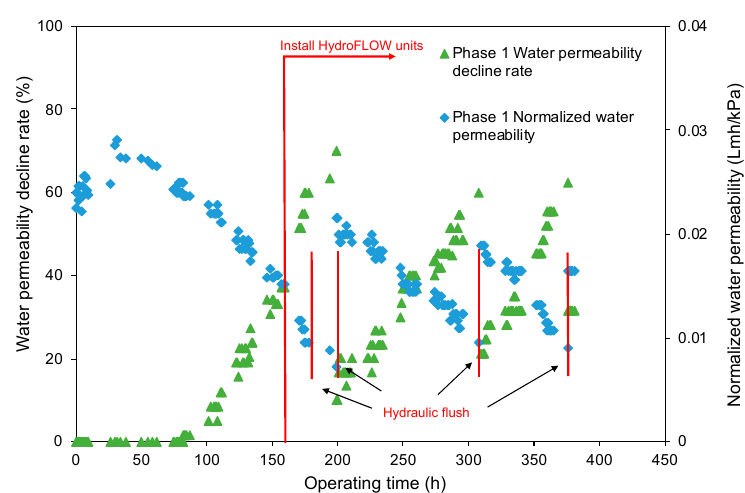
Figure 3. ( a ) Comparison of normalized water permeability, ( b ) Comparison of water permeability decline rate from 77 h (water recovery reached 50%) to 150 h of desalination, with (Phase 2) and without (Phase 1) HydroFLOW devices.